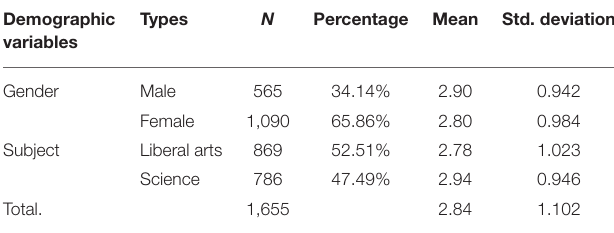
TABLE 1 | The specific composition of the